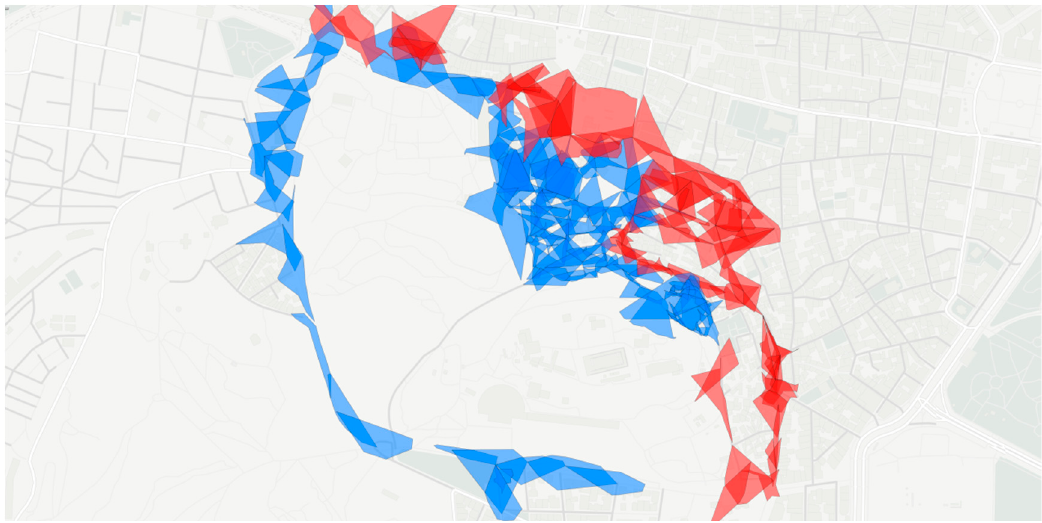
Figure 19. Coverage by process polygon visualization. Different colors indicate different working groups (Group A is indicated in blue and Group B in red).